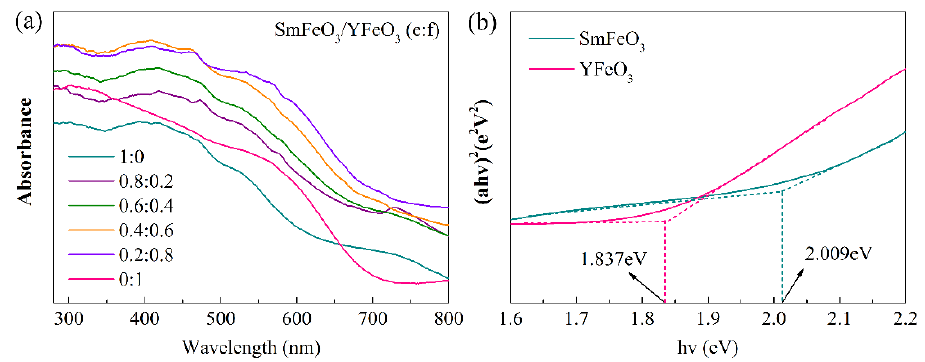
Figure 14. ( a ) The UV–visible absorption spectrum of SmFeO 3 /YFeO 3 (e:f) powder samples; ( b ) the ( ahv ) 2 –( hv ) curves of SmFeO 3 and YFeO 3 powder samples.